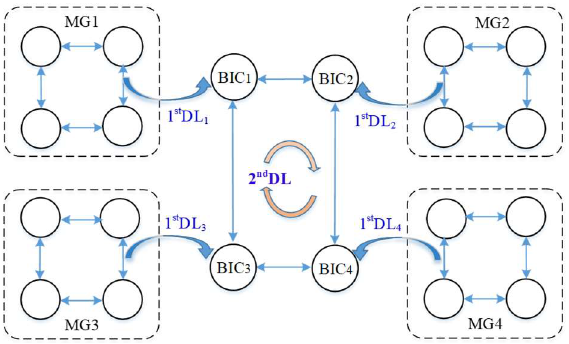
Figure 3. Core idea of the proposed multilevel dynamic master-slave control strategy.